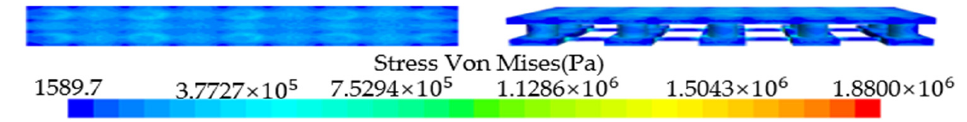
Figure 8. Stress under non-operational sea state. Figure 9. Stress under operating sea state.